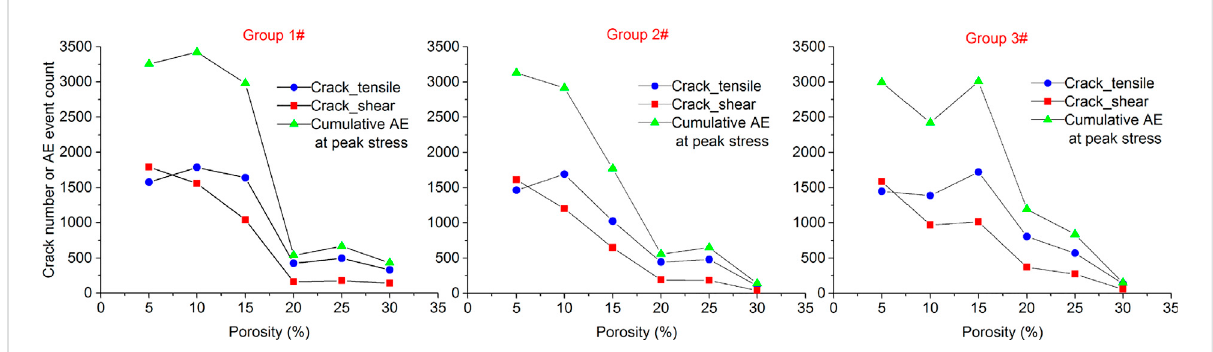
Crack number and AE event count of the models at peak stress with increasing defect porosity.